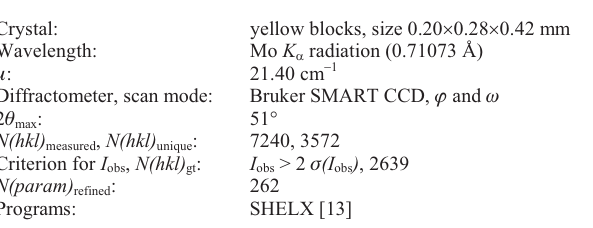
Table 1. Data collection and handling.